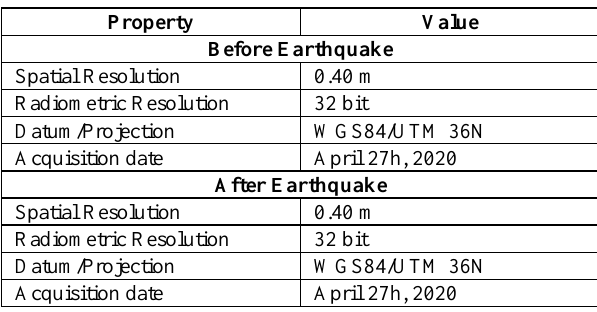
Table 1. Properties of the optical satellite image. The used optical images are found in Figure 3.